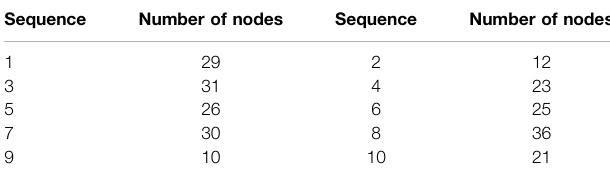
TABLE 3 | The node ’ s in fl uence degree sorting table.